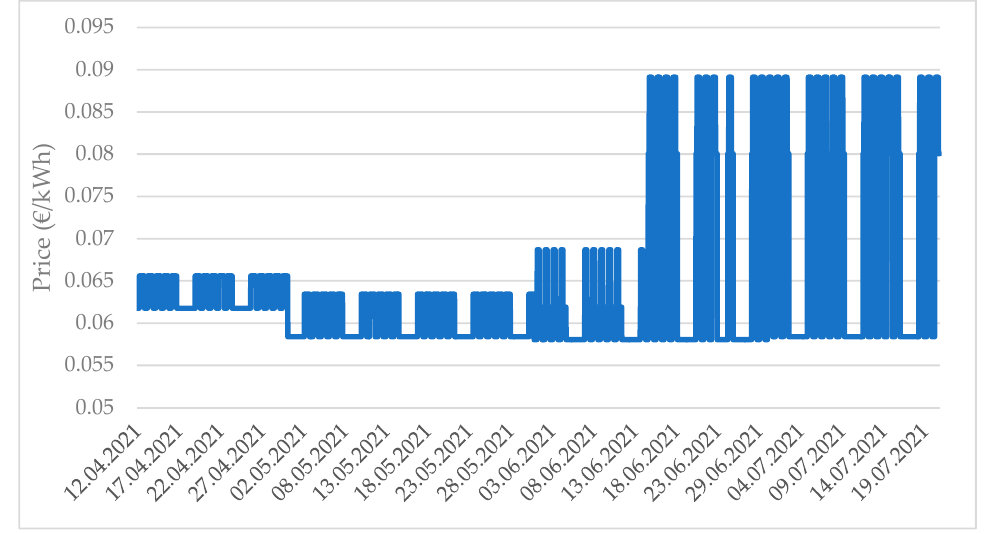
Figure 7. Electricity prices of the swimming pool. The prices were changed several times during the testing period. A two-tier tariff system was used for April and May with 0.058388 lowest and 0.06559 highest. For June and July, a three-tier tariff system was used with 0.058043 lowest and 0.0891 highest.